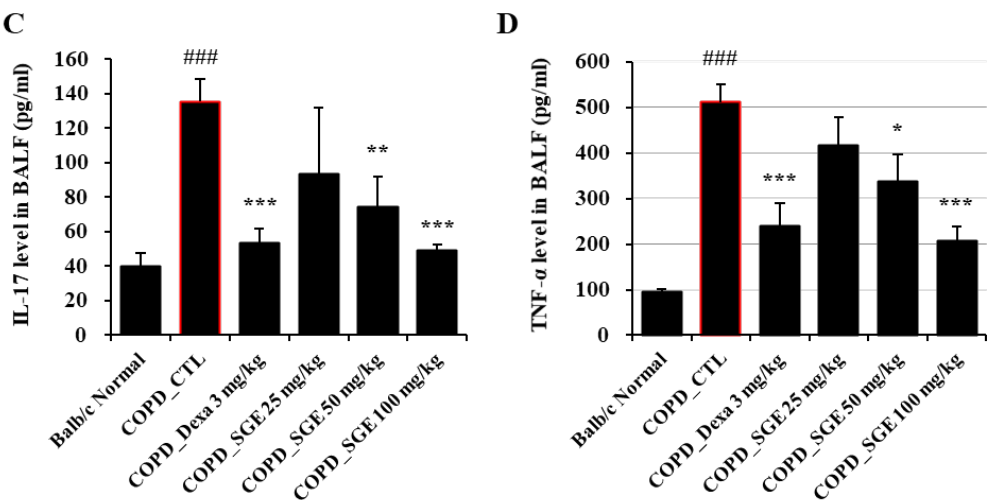
Figure 4. Effects of SGE on cytokine production in BALF of COPD-induced mice. Production of ( A ) MIP2, ( B ) CXCL1, ( C ) IL-17, ( D ), and TNF- α in BALF of COPD-induced mice was measured by ELISA. The data are presented as means ± SEM (n = 6 mice) for individual mice. ## p < 0.01, ### p < 0.001 compared to normal, and * p < 0.05, ** p < 0.01, and *** p < 0.001 compared to control. Dexa, dexamethasone.